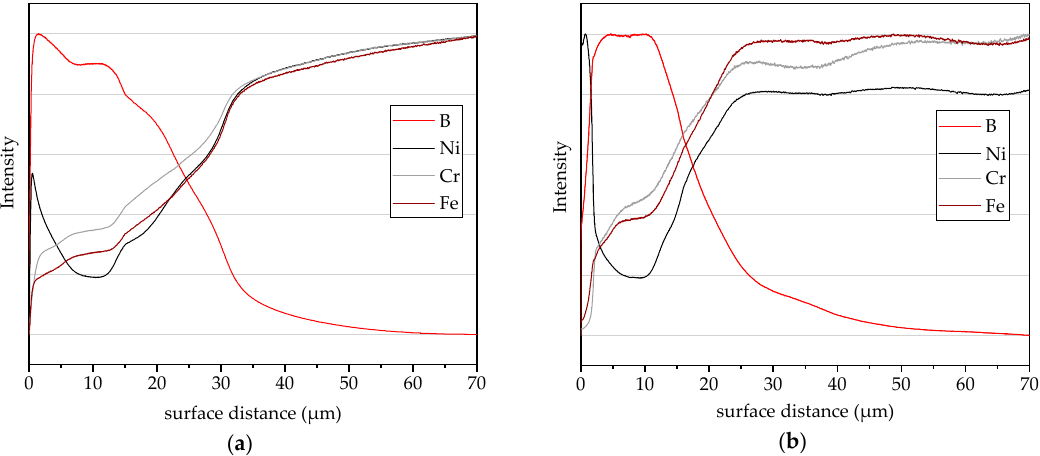
Figure 2. Qualitative depth profiles determined by glow discharge spectroscopy (GDOS): ( a ) cast CrFeCoNi in borided state; ( b ) borided HVOF coating CrFeCoNi.